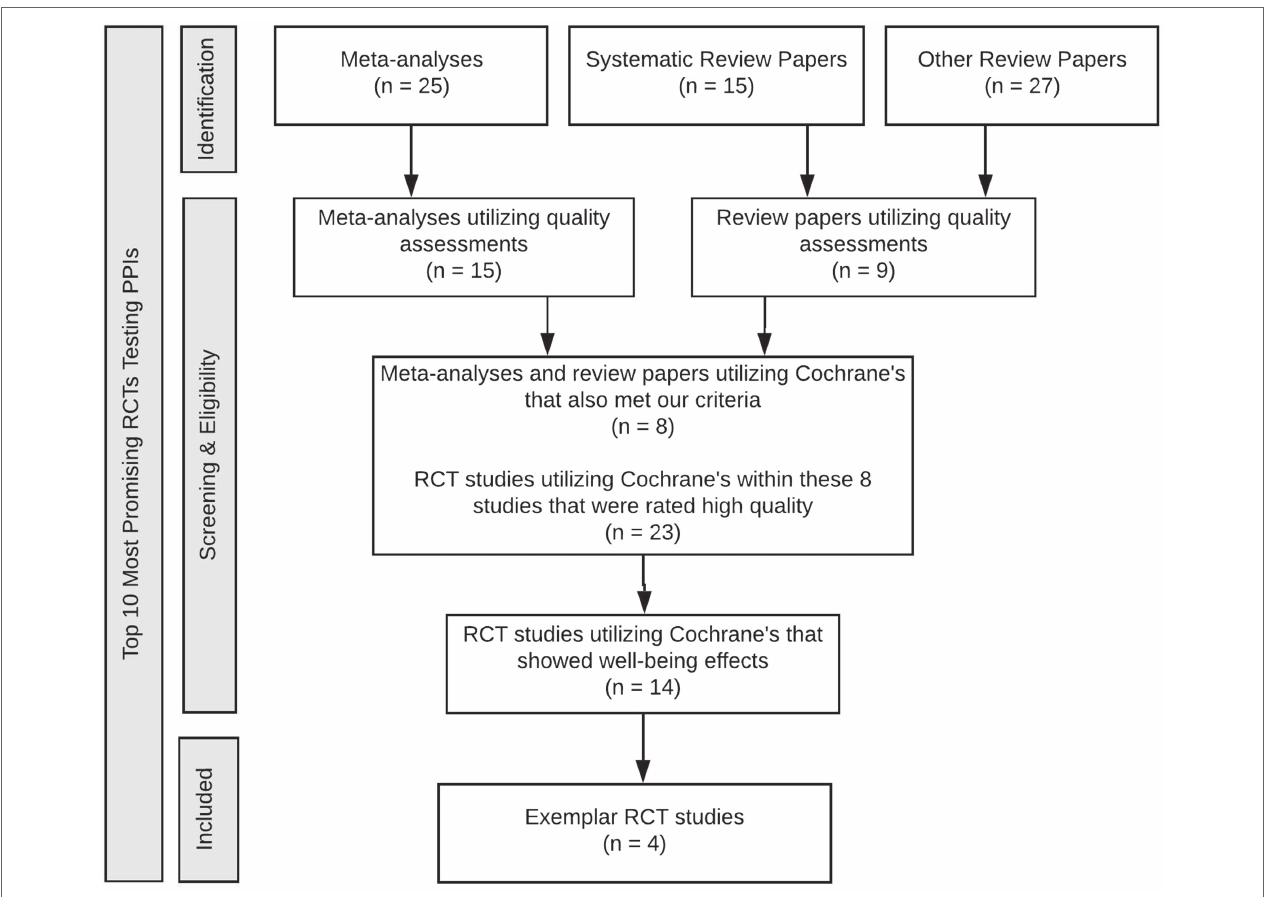
FIGURE 1 | Flow diagram of the search and selection procedure for target